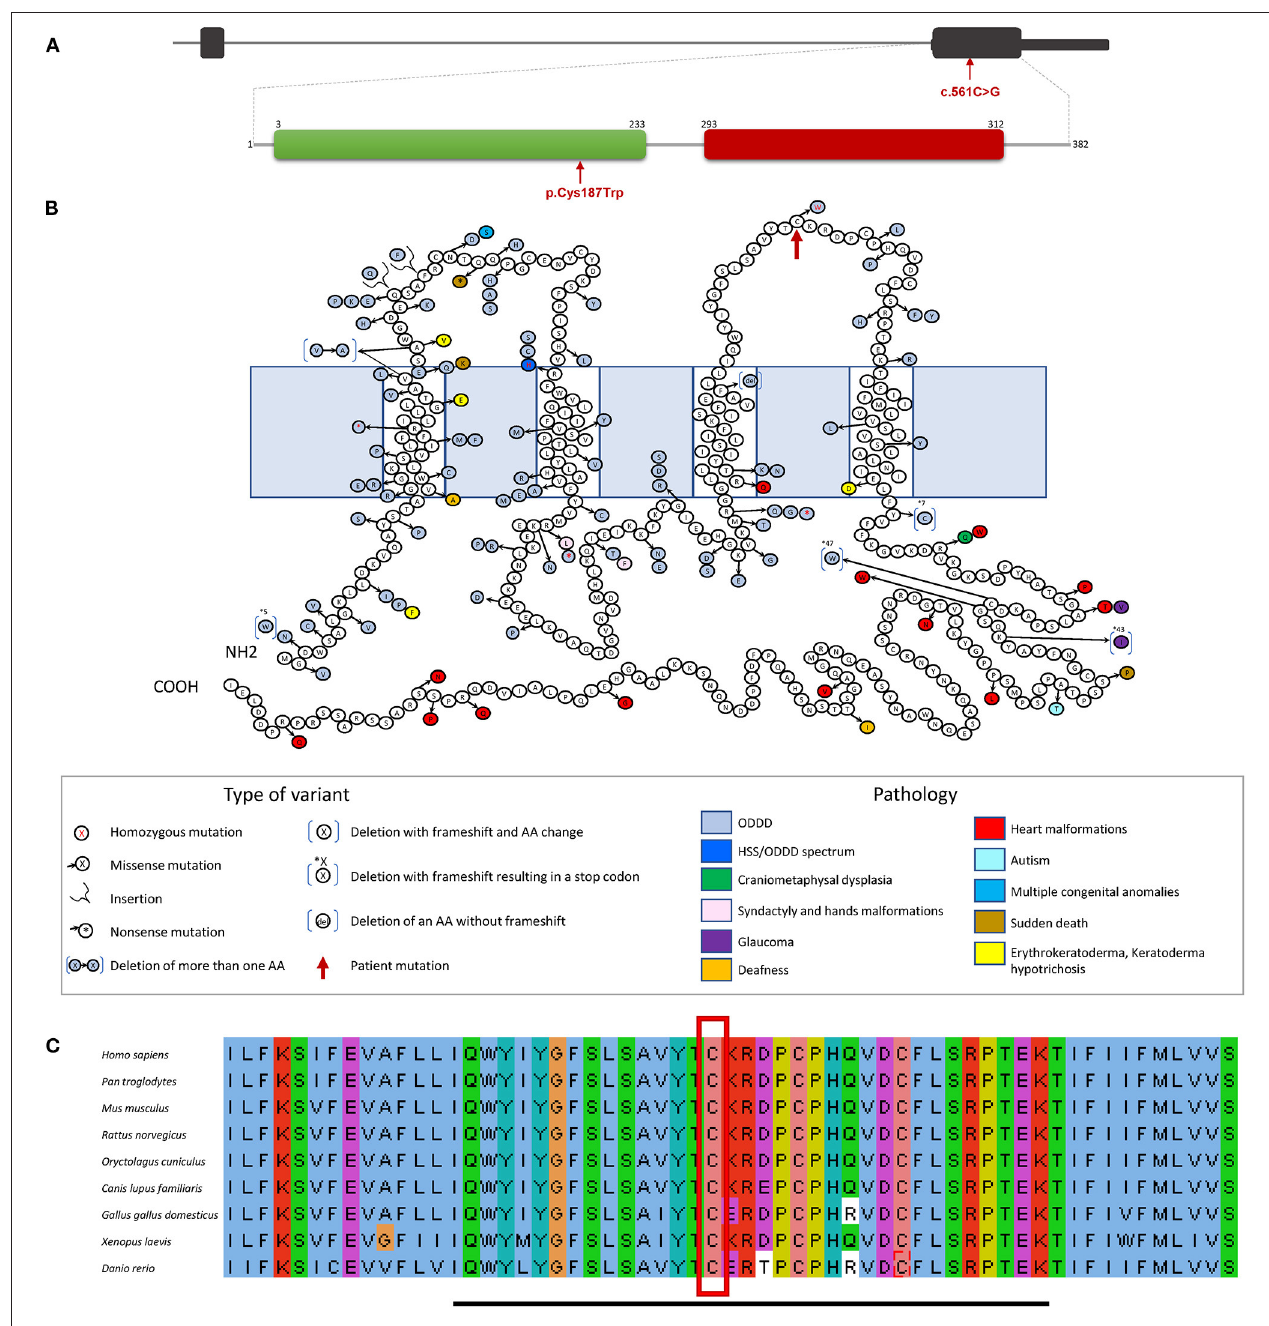
FIGURE 3 | GJA1 gene and protein structure. (A) GJA1 is a two exons gene (black boxes) with the entire protein coding sequence included within exon 2. The protein contains two domains, a connexin domain (green box), and a connexin43 domain (red box). The variant identified in our patient is in exon 2 (red arrow), encoding the connexin domain (green box) of the protein modifying an amino acid in the second extracellular loop. (B) The protein structure shows the different amino acid changes and subsequent corresponding diseases reported so far, ODDD is represented in light blue. The new homozygous variant (c.561C > G p.Cys187Trp) discovered in our patient (red arrow) is located in the sequence area coding for the protein second extracellular loop. (C) Multiple sequence alignment of the second extracellular loop of the CX43 is indicated by the black bar. The amino acid, a cysteine (C), becoming tryptophan (W), as a consequence of the missense alteration (red square) is conserved, through evolution, from Homo sapiens to Danio rerio